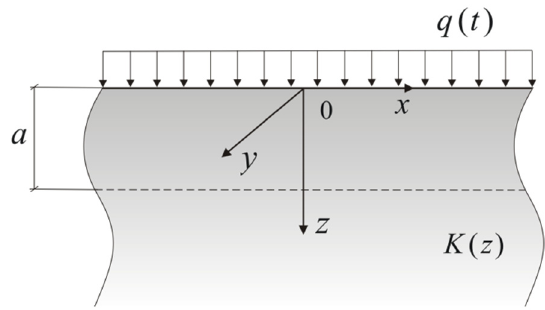
Figure 1. Scheme of the heating of the FGM semi-space.